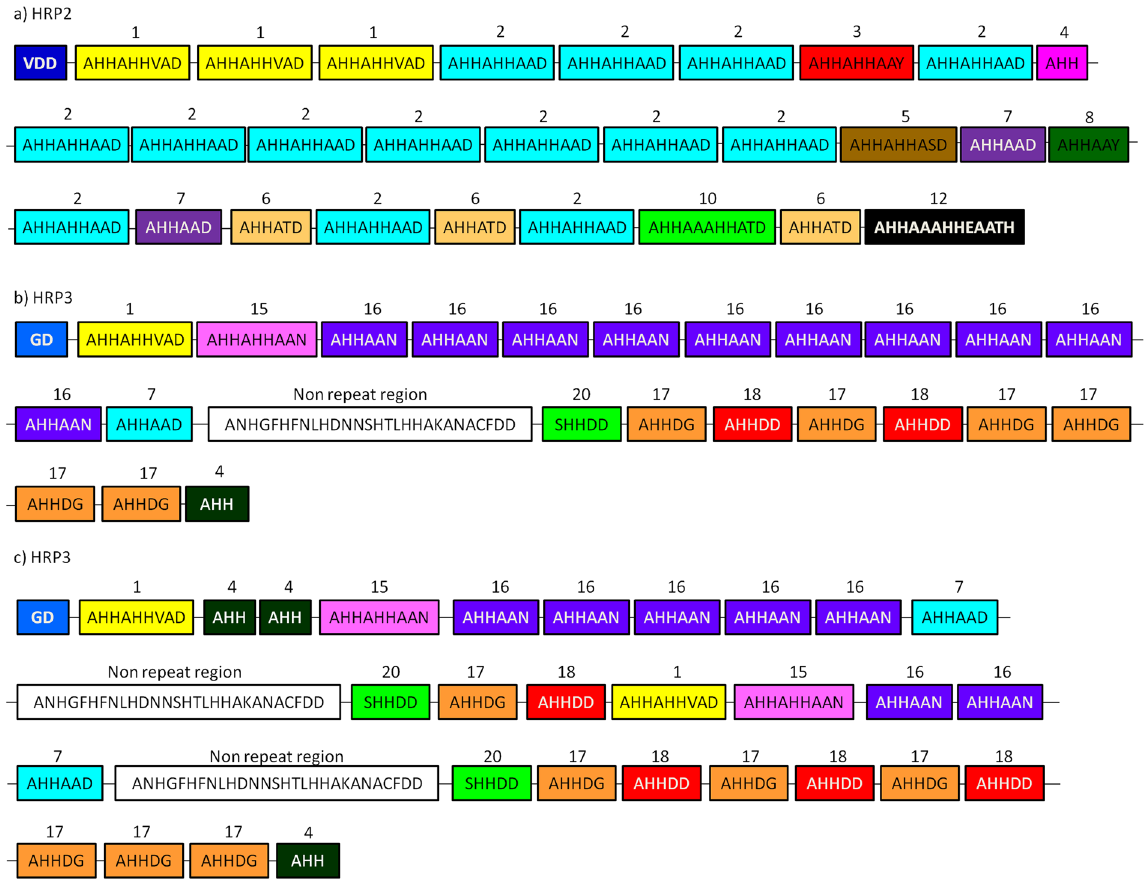
Figure 1. Schematic diagram showing location and arrangement of amino acid repeats in the P. falciparum protein among Indian isolates based on present study. In both the HRP2 and HRP3, repeat region start from the type 1 repeat (AHHAHHVAD). In HRP3 few isolates were having one non-repeat region while other were having two non-repeat region. (a ) Showing arrangement of repeats in Pf HRP2, ( b ) and ( c ) showing arrangement of repeats in Pf